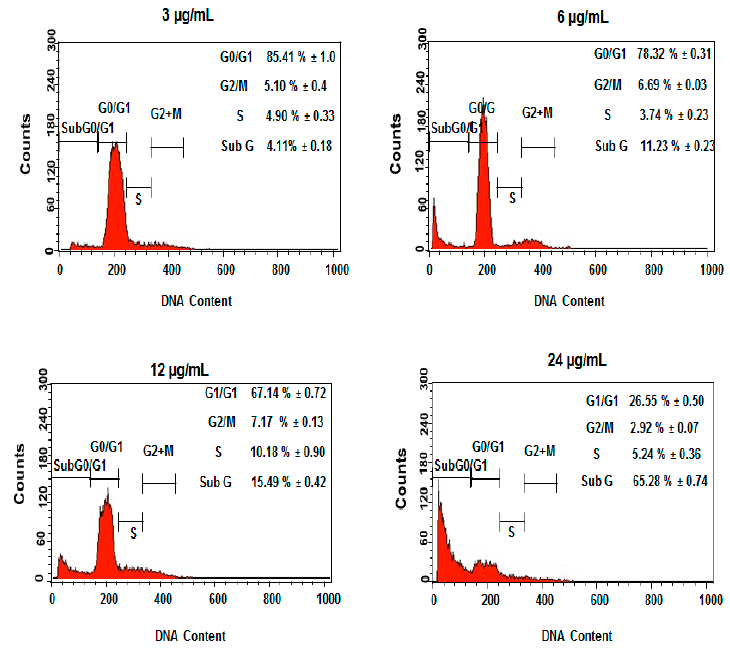
Figure 8. The concentrations (3, 6, 12 and 24 µg/mL) of DEN in HT29-treated cells included G2/M cell cycle arrest. Results are represented one of the three independent experiments.